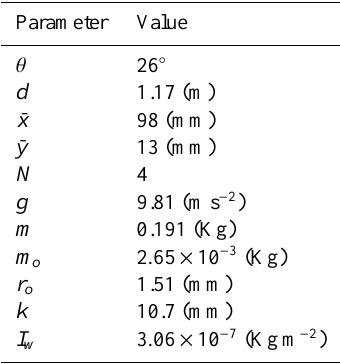
Table 1. Parameters used for energy balance trend